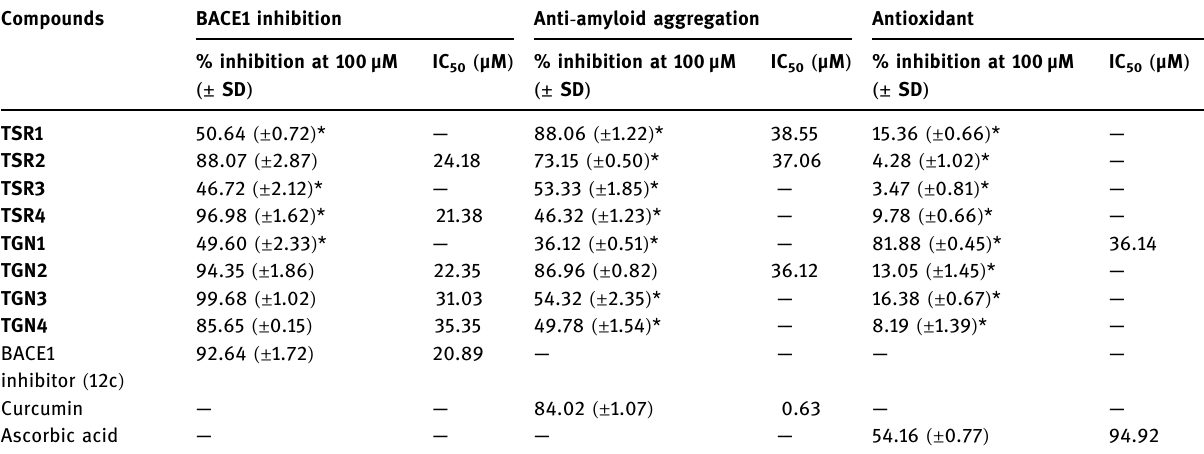
Table 2: Multifunctional activity of TSR and TGN compounds Compounds BACE1 inhibition Anti - amyloid